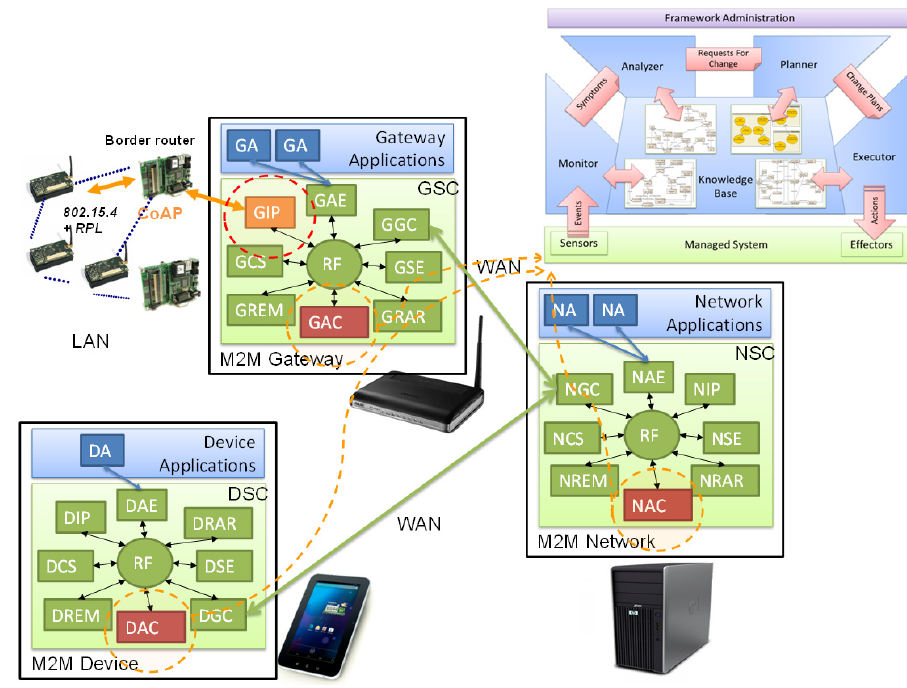
Figure 19. The main components of the smart metering